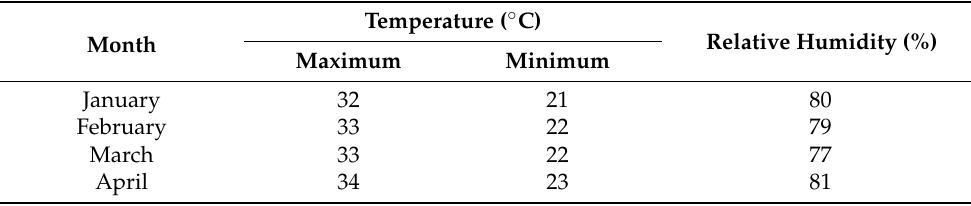
Table A3. Monthly average temperature and humidity during the